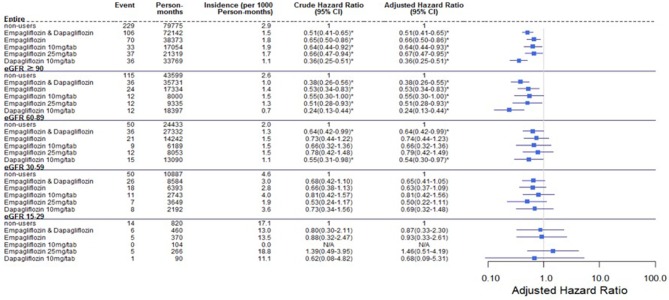
Cox proportional hazard models for decrease in eGFR over 40% in patients receiving sodium–glucose cotransporter 2 inhibitors and other drugs. The probability of a decrease in eGFR over 40% is shown for empagliflozin 10 mg/tab, empagliflozin 25 mg/tab, and dapagliflozin 10 mg/tab users vs. non-users in different renal function subgroups. eGFR, estimated glomerular filtration rate.